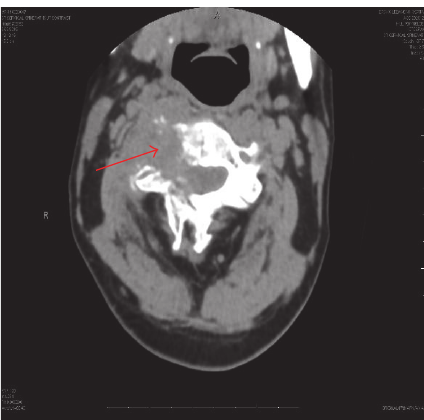
Figure 1: CT spine showing a mass at level of C3 with marked osseous destruction.